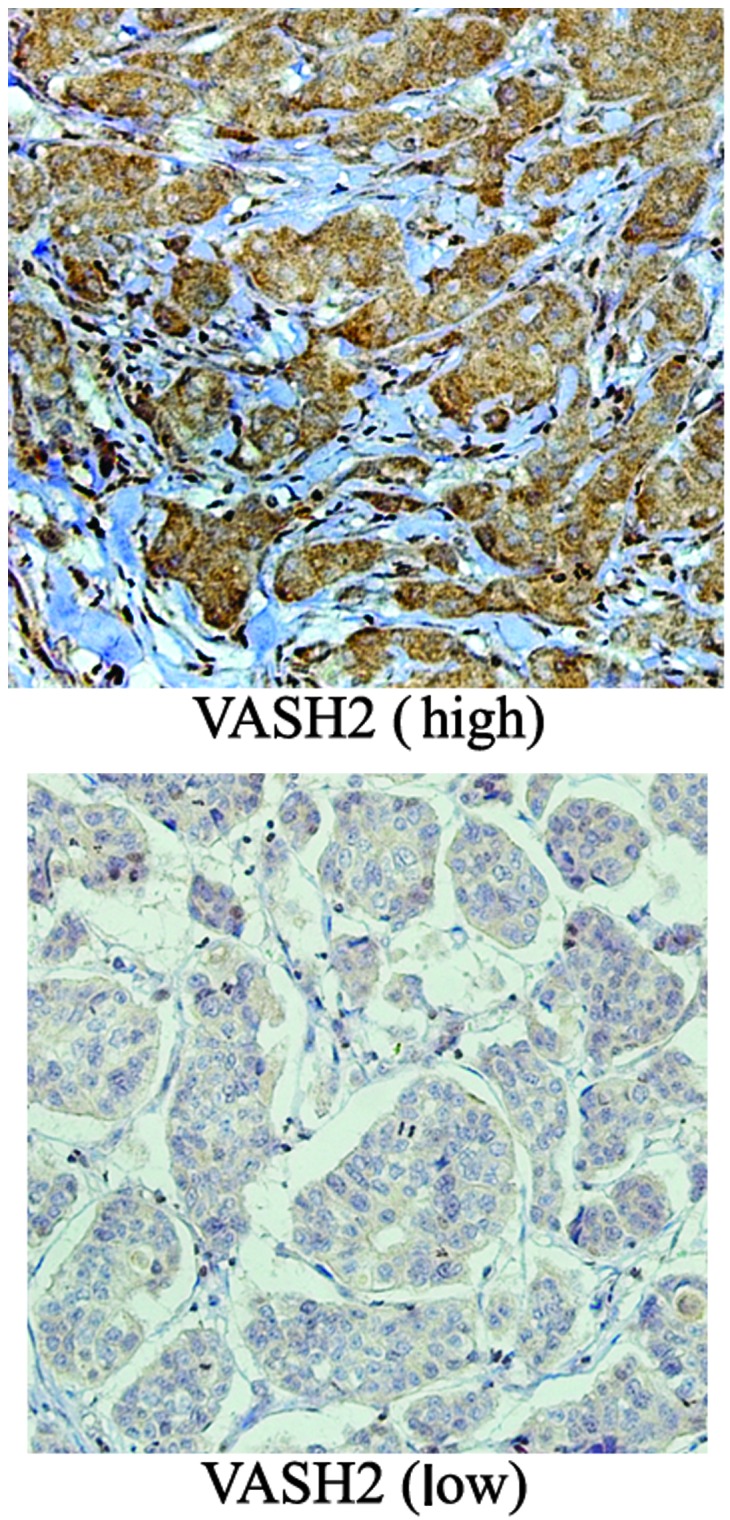
Representative images of VASH2 staining in human breast cancer tissues. Magnification, ×200. VASH2, vasohibin-2.